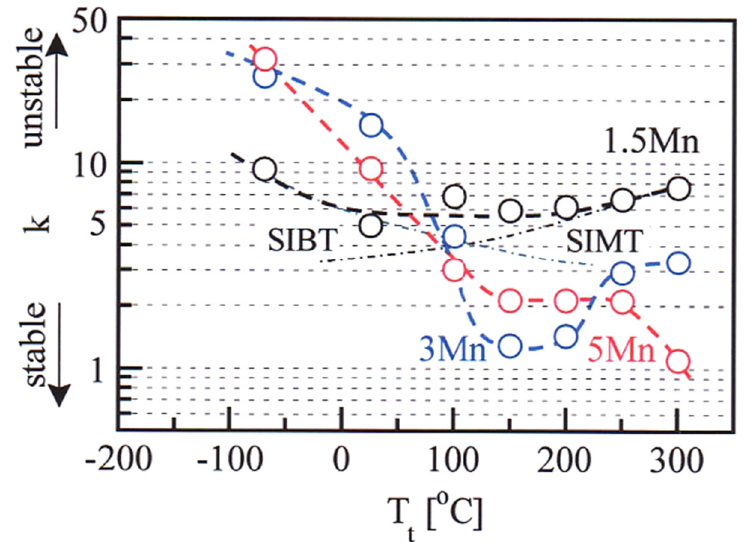
Figure 13. Variations in k -value with tensile test temperature ( T t ) in the 1.5 Mn, 3 Mn and 5 Mn steels subjected to the IT process [36]. “SIMT” and “SIBT” represent the strain-induced martensite and bainite transformation, respectively. Reprinted with permission from Wily-VCH GmbH, Weinheim: Steel Res. Int., Copyright 2021.